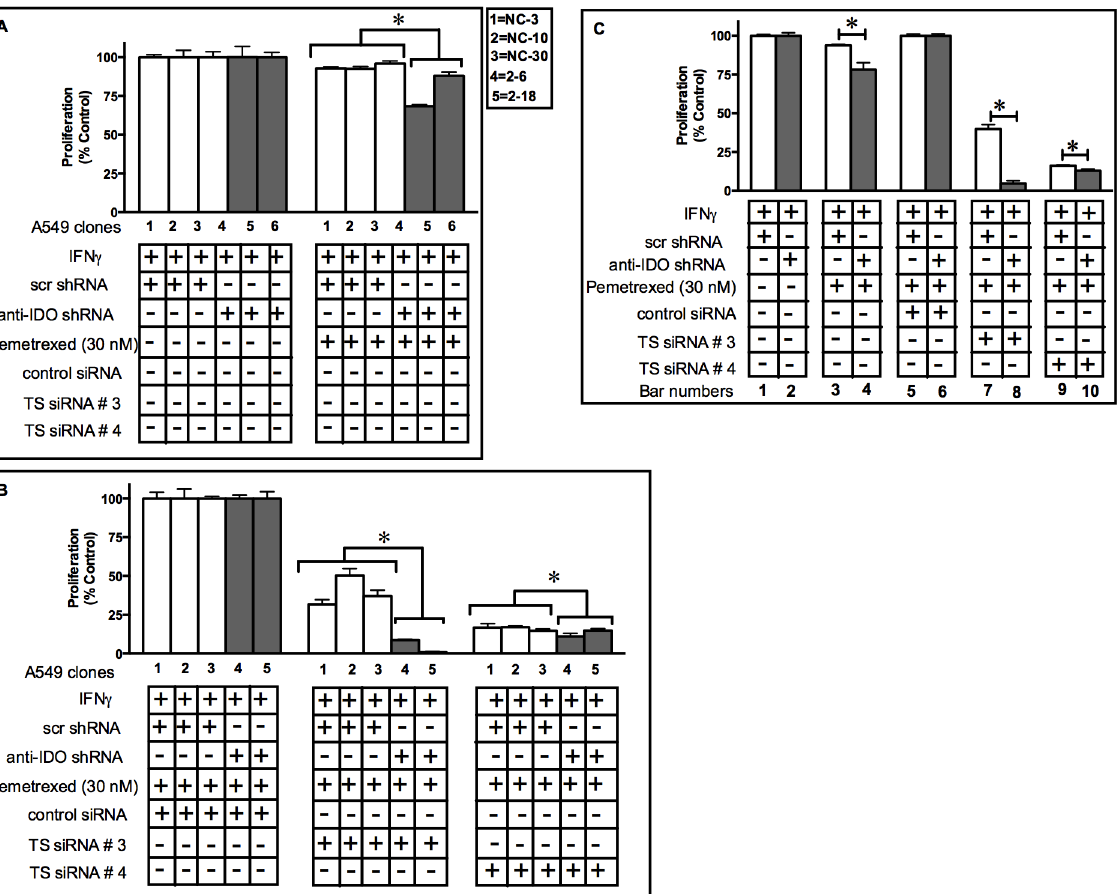
Fig 7. Concurrent IDO and TS downregulation sensitizes A549 cells to pemetrexed more than IDO knockdown alone. A549 cells were transfected with scrambled, non-targeting control siRNA or anti-thymidylate synthase (anti-TS) siRNA, treated with IFN γ (25 ng/ml) for 48 h, pemetrexed (30 nM) for 72, and then enumerated. Bars indicate mean relative cell numbers (n = 3 ± SD). A : Proliferation of clonal A549 cell populations induced with IFN γ and then treated with pemetrexed, but untransfected with siRNA of any kind. Gray bars : clones containing anti-IDO shRNA. White bars : clones containing scrambled, non-targeting control shRNA. B : Proliferation of the same clonal A549 cell populations transfected with scrambled, non-targeting control siRNA, TS siRNA #3, or TS siRNA #4, induced with IFN γ , and then treated with pemetrexed. Bars represent values normalized to values obtained from clones treated with IFN γ but untreated with pemetrexed or siRNA; those cells were each considered to have a proliferation value of 100% after IFN γ treatment. Gray bars : clones containing anti-IDO shRNA. White bars : clones containing non-targeting control shRNA. * Significant difference, Student's t -test, p < 0.05. Data presented a representative experiment from two independent experiments. Results are normalized to control cells not treated with pemetrexed, but with treated with IFN γ . Panel C : shows the pooled results from panel A and B.